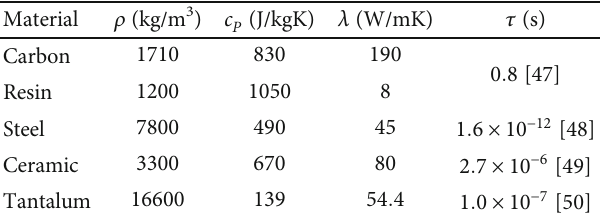
Table 1: Thermal properties [46].